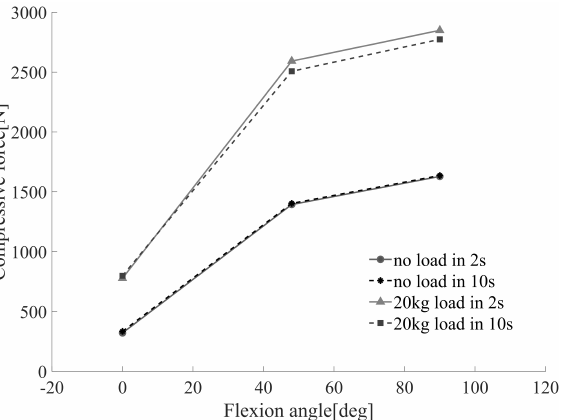
Figure 6. Compressive force (CF) estimated by CF simulator at 0 ◦ , 48 ◦ , and 90 ◦ with and without a 20 kg external